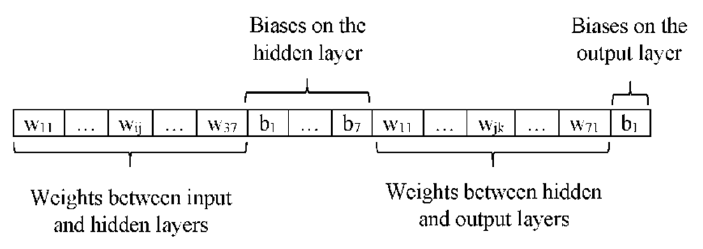
Figure 2. Schematic view of a vector containing all weights and biases of an ANN with seven neurons in the hidden layer.